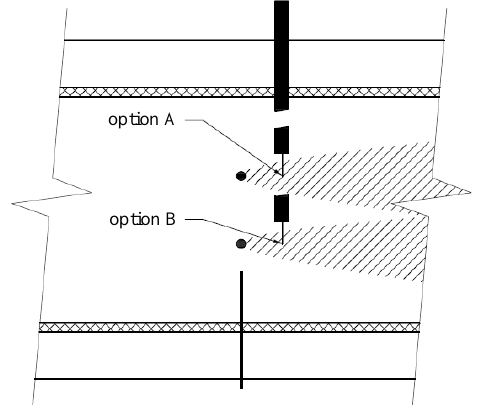
Fig. 4. Measuring area for frequency measurement. Option A measurement behind the cooled cylinder, option B measurement behind the reference